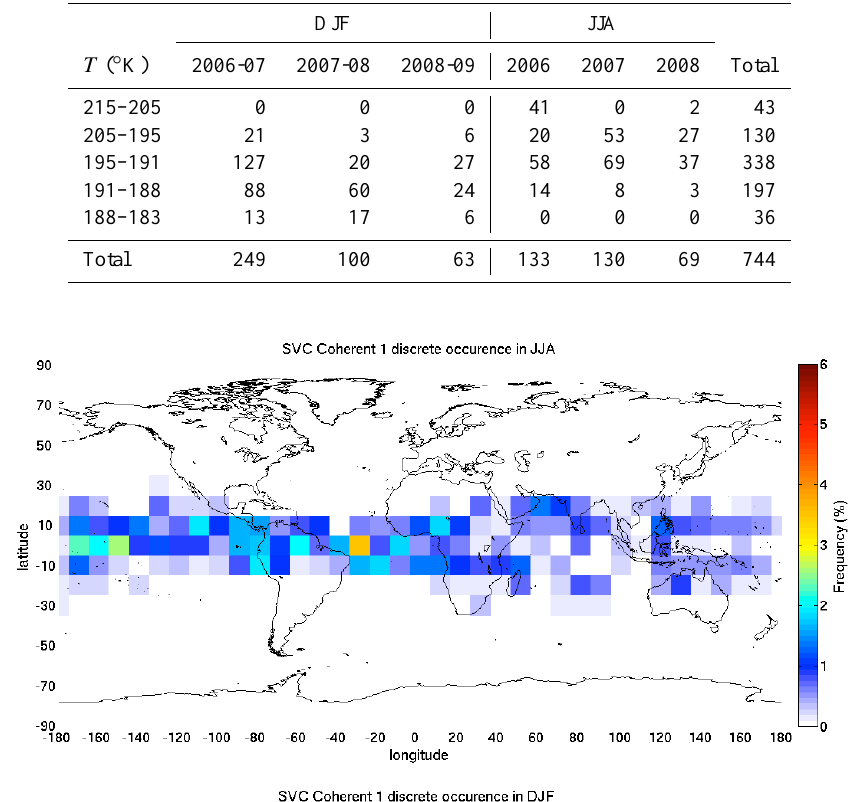
vs. temperature (Fig. 8, top), and of depolarization vs